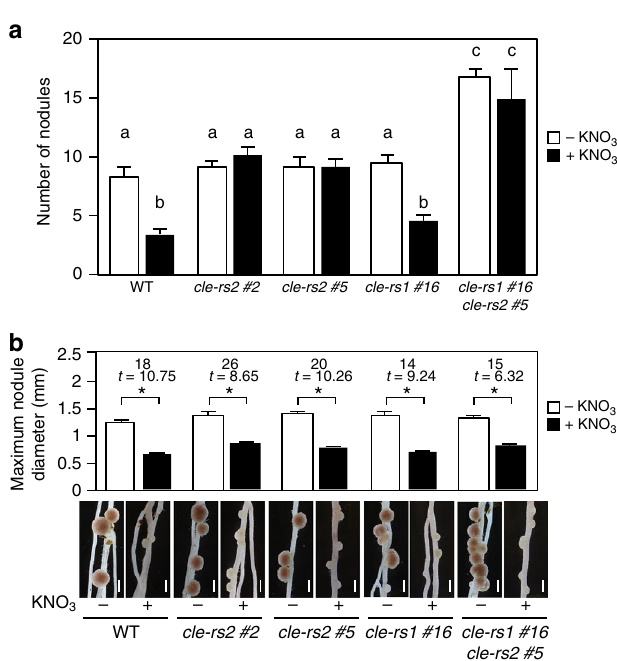
Fig. 7 Effects of loss-of-function mutations in CLE-RS1/2 on nodulation. a The number of nodules and ( b ) maximum nodule diameter (mm) in WT, the cle-rs1 mutants (T2), the cle-rs2 mutants (T2), and the cle-rs1 -rs2 double mutants grown in the presence of 0 or 10 mM KNO 3 ( n = 7 – 14 plants). The cle-rs1 -rs2 double mutants were obtained by crossing the single mutants. The cle-rs1 and -rs2 mutants were obtained by the CRISPR/Cas9 genome- editing system (Supplementary Fig. 9a). Error bars indicate SEM. Columns with the same lower-case letter indicate no signi fi cant difference (Tukey ’ s test, P < 0.05; a ). * P < 0.05 by Student ’ s t -test. Degrees of freedom are shown above the t -values ( b ). Scale bars: 1